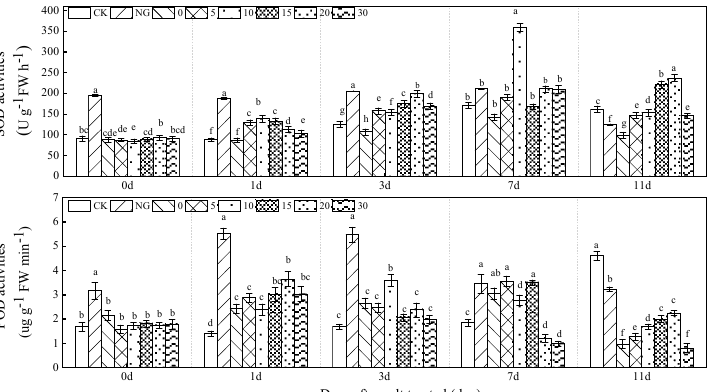
Figure 2. SOD and POD activities of cucumber seeding leaves as affected by grafting and Ca 2+ treatments under salt stress. Bars represent standard errors. Different letters indicate a significant difference in the same parameter between treatments at p <